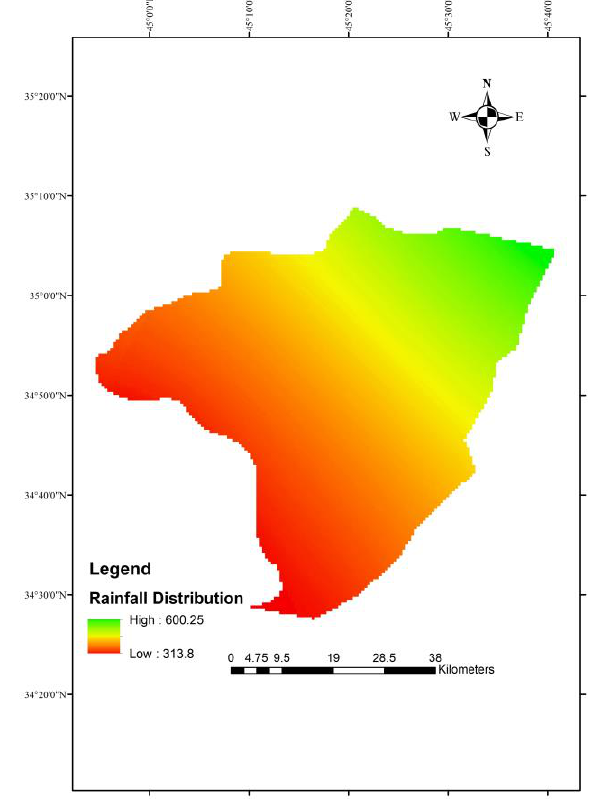
Figure 5. Rainfall map of the study area.